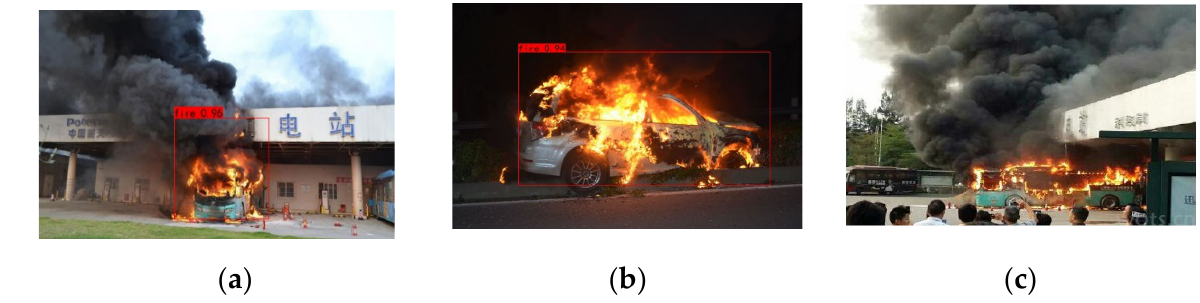
Table 6. Comparison of different model evaluation index parameters.